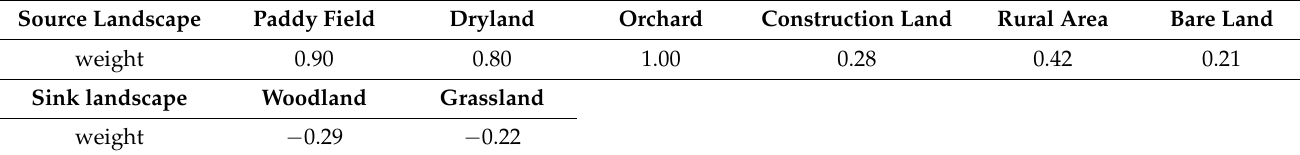
Table 1. The source and sink landscape types of the Jiulong River watershed and the NPS pollution weights. Source Landscape Paddy Field Dryland Orchard Construction Land Rural Area Bare Land weight 0.90 0.80 1.00 0.28 0.42 0.21 Sink landscape Woodland Grassland weight − 0.29 −